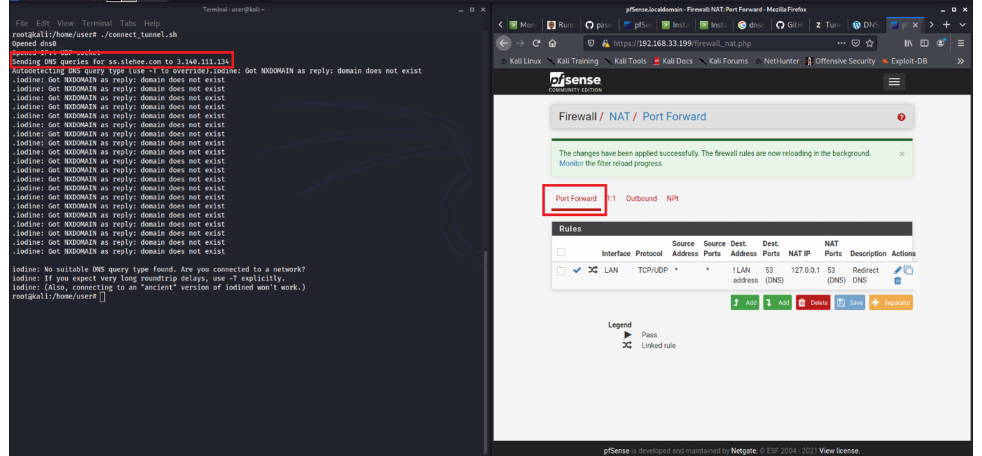
Figure 6. Webserver hosted in a non-cloud environment: Iodine connection failed because port 53 is blocked by the virtual firewall.